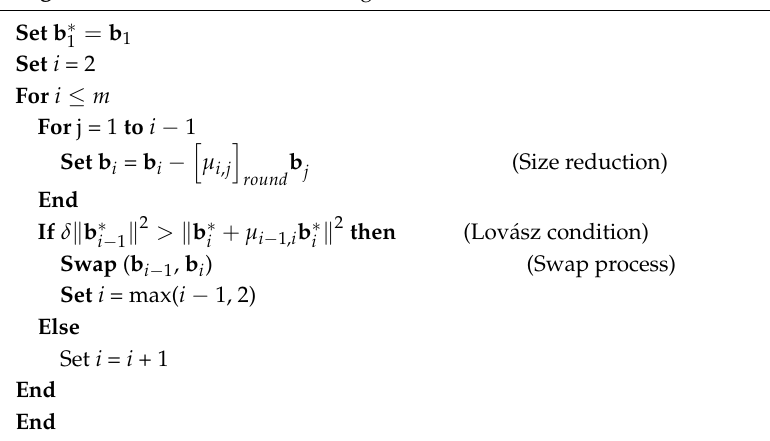
Algorithm 1: The LLL reduction